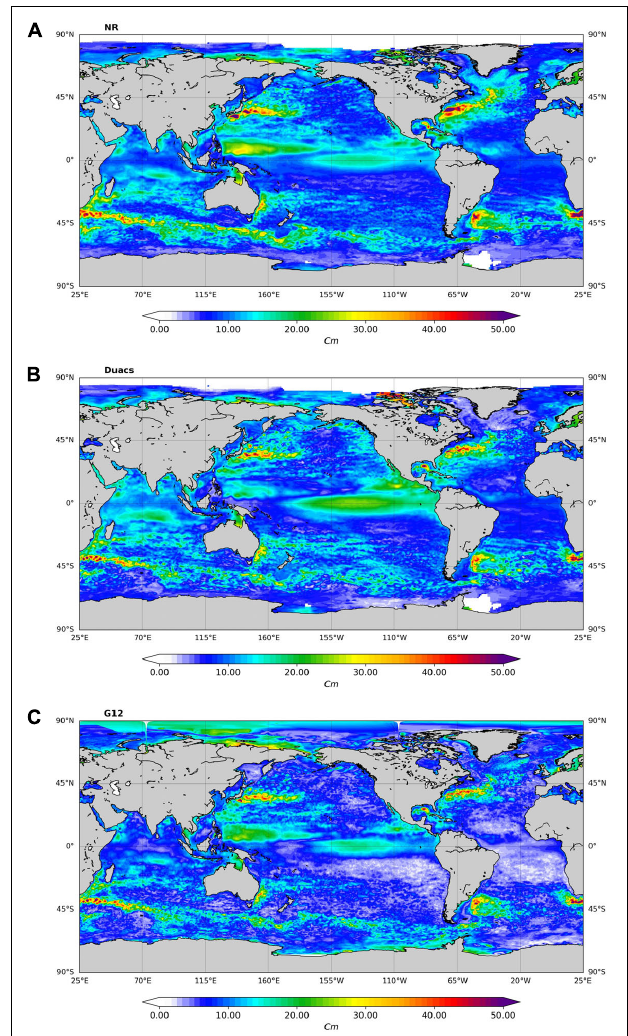
FIGURE 2 | Root Mean Square (RMS) of the sea level anomalies (cm) over 2015: NR (A) , Duacs (B) , and G12 (C) .